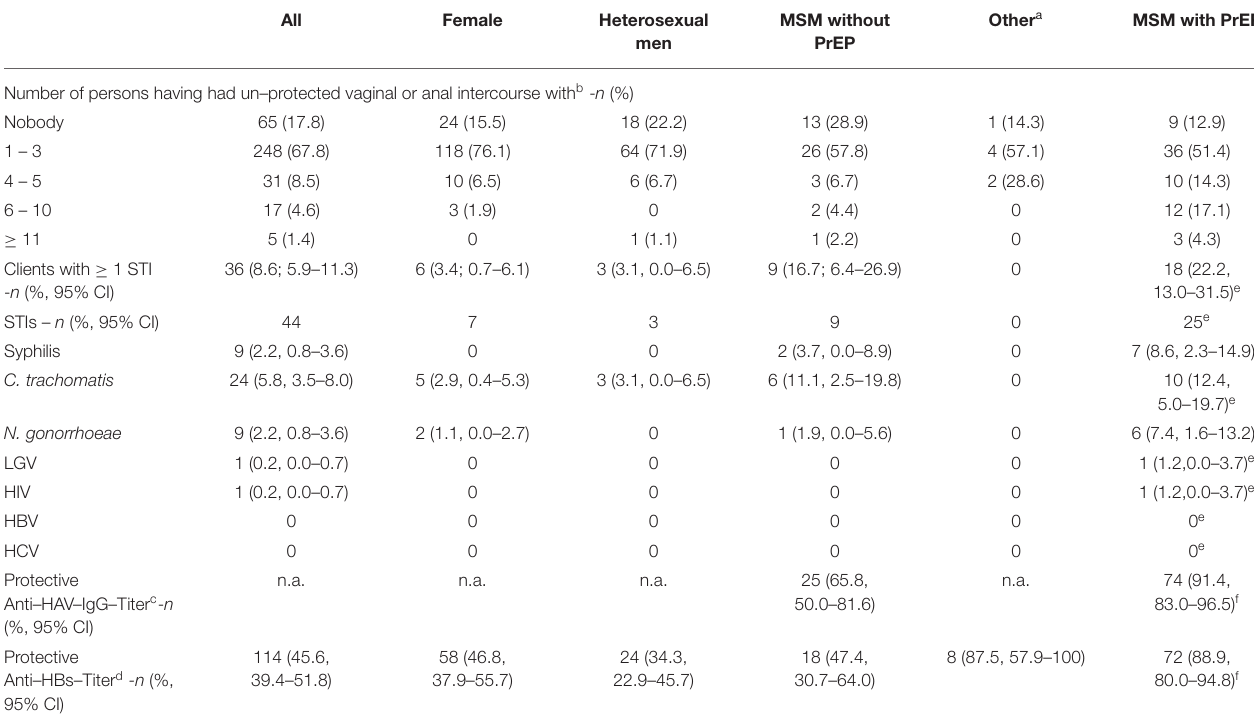
TABLE 2 | Sexual behavior and health of clients presenting at the Center for Sexual Health Freiburg, Germany, between 1 May 2020 and 28 February 2021. All Female Heterosexual MSM without Other a MSM with PrEP men PrEP Number of persons having had un–protected vaginal or anal intercourse with b - n